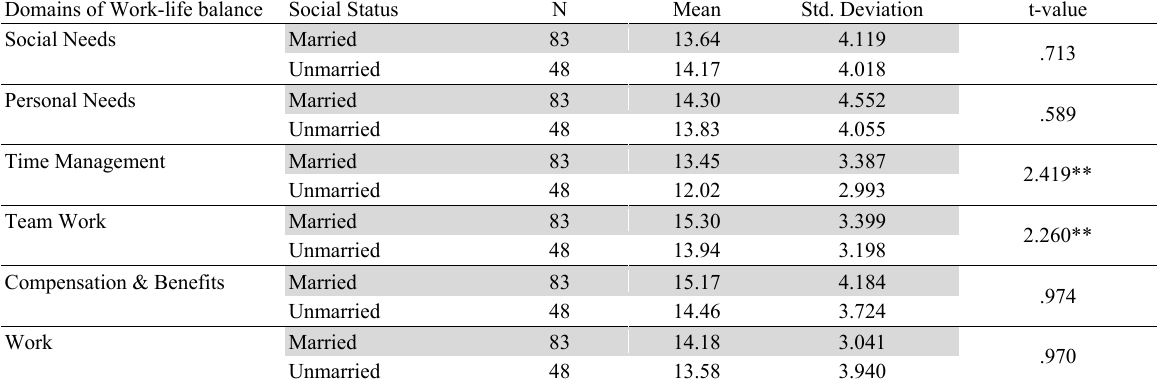
Domains of Work-life balance